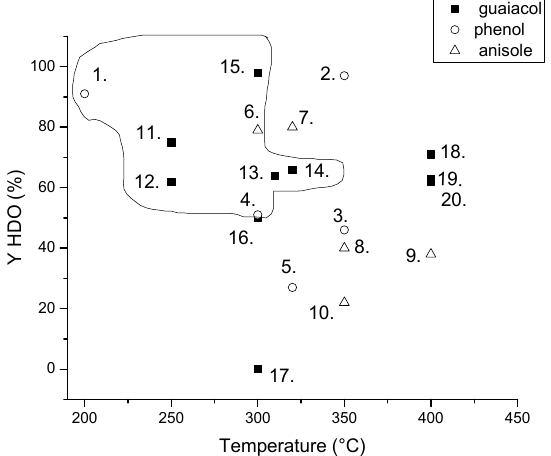
Figure 3. Hydrodeoxygenation (HDO) yield in phenol, anisole and guaiacol HDO over different catalysts as a function of temperature. Notation: For phenol 1. CoNx, 20 bar, cyclohexane [63], 2.